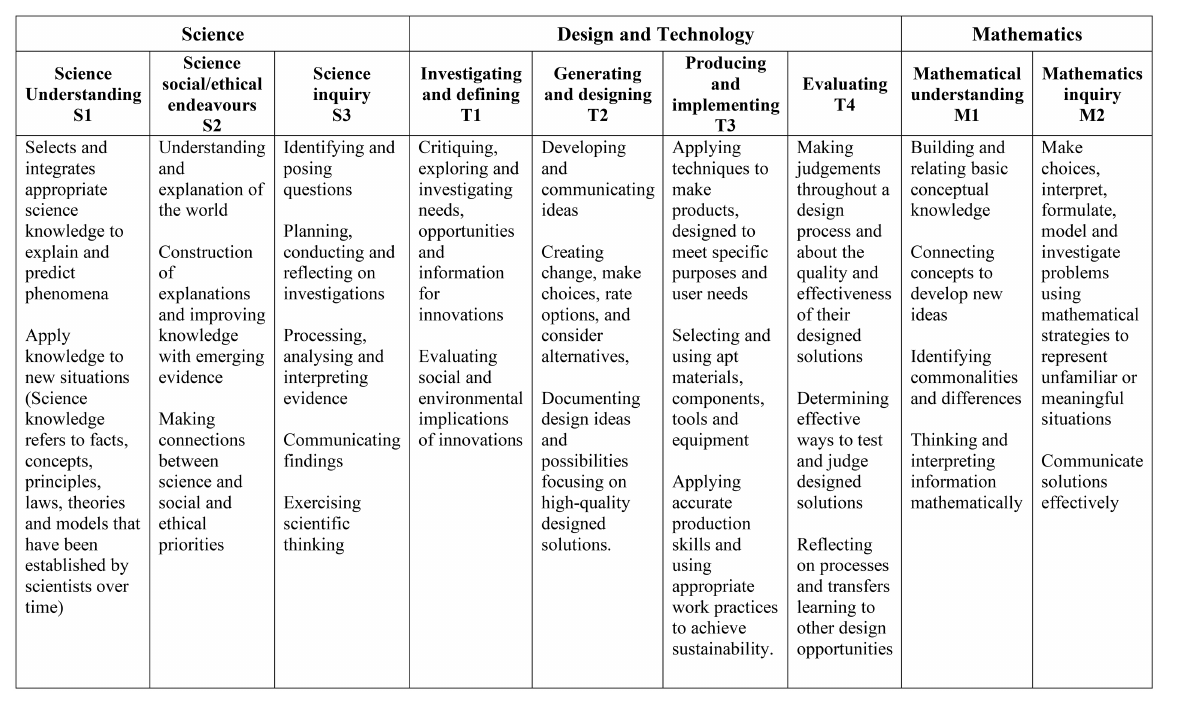
FIGURE 1 Science, Design and Technology and Mathematics competency